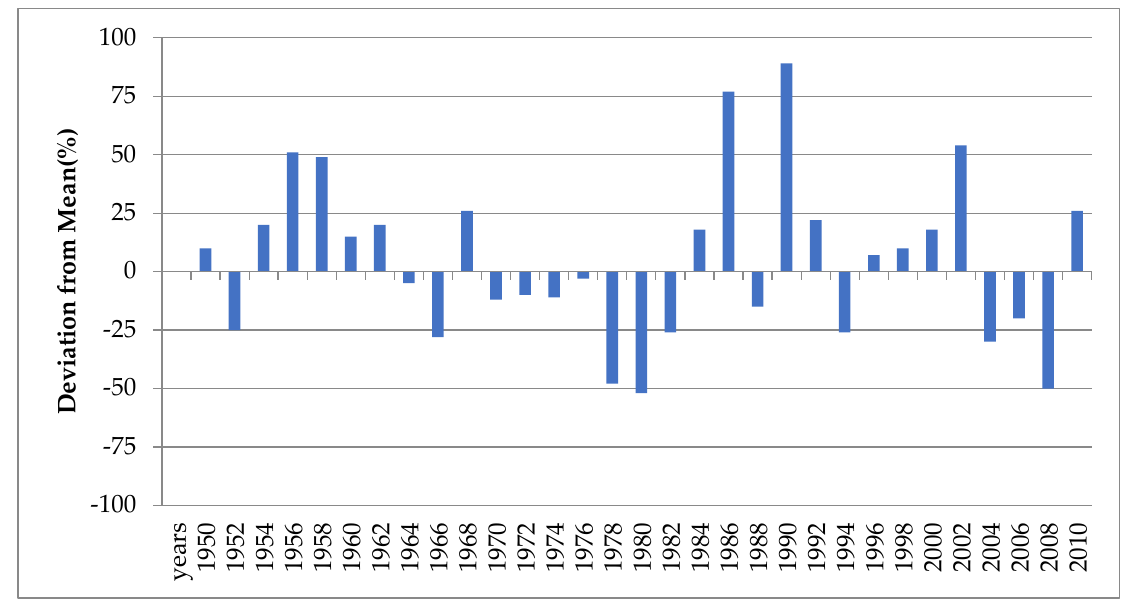
Figure 12. Chodavaram.